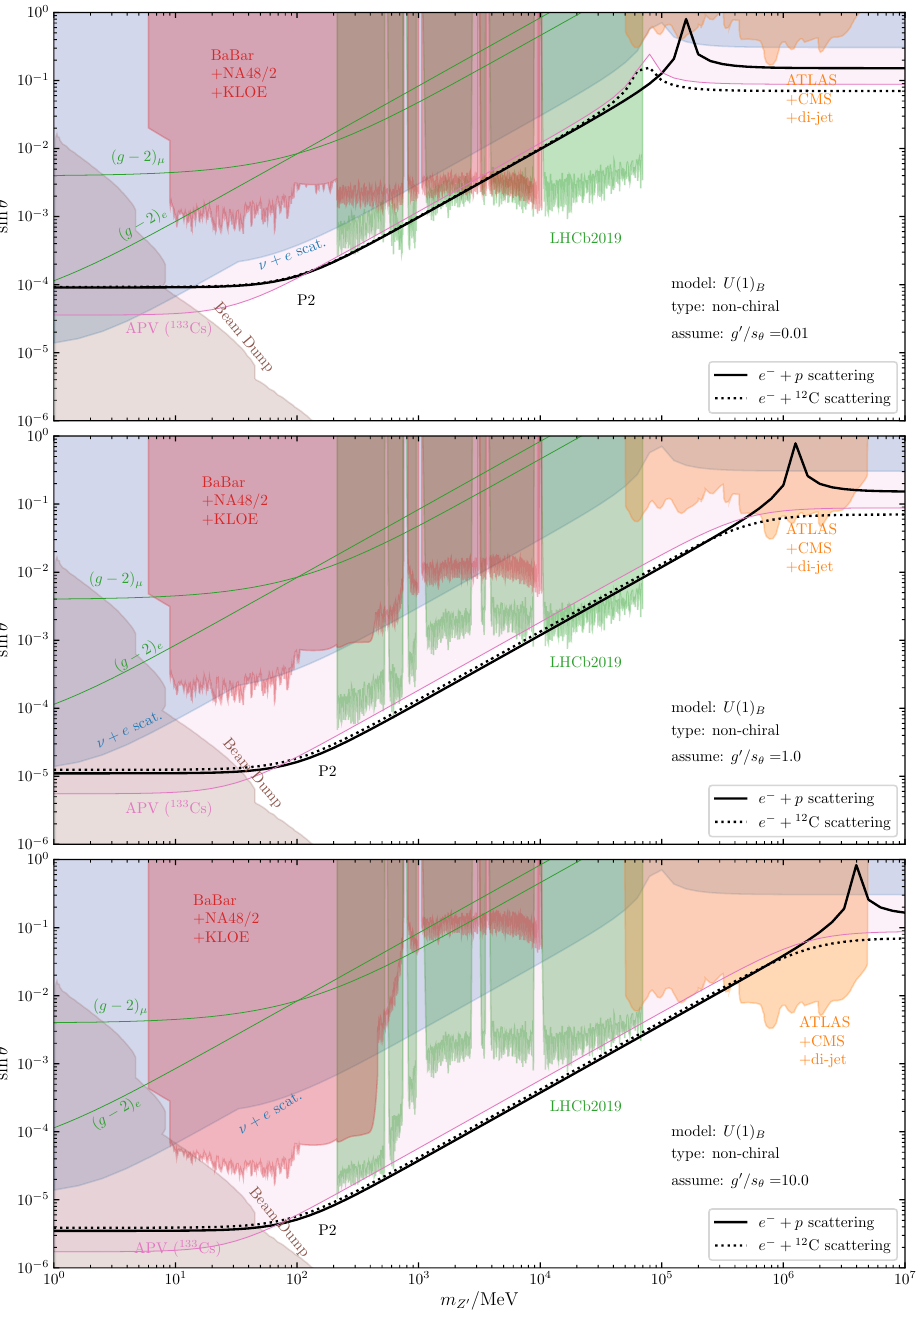
Figure 5 . Sensitivity of the P2 experiment to the chiral U(1) B model with mass mixing sin θ and the three values of g 0 / sin θ = 0 . 01 (upper), 1 (middle) and 10 (lower). The notations are the same as in figure